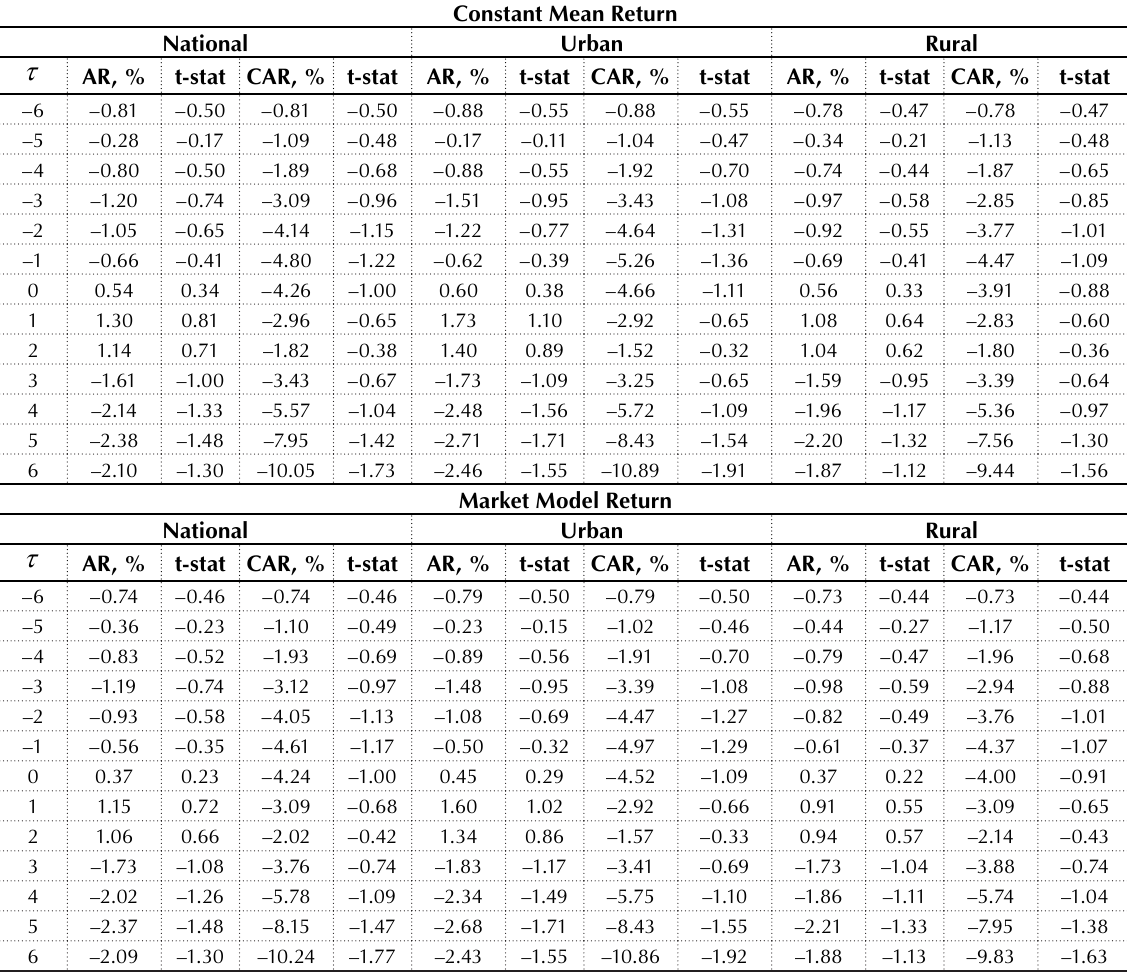
Table 5. Effect of the introduction of the non-farm land use tax law on housing